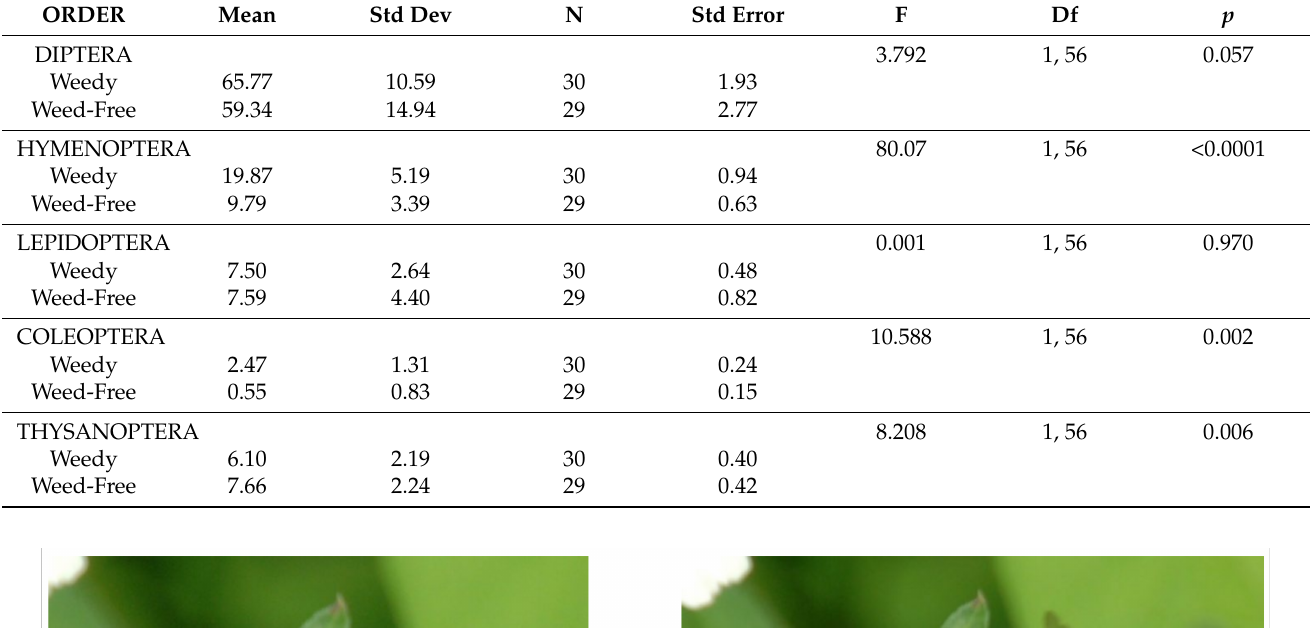
Table 2. Insect orders on mango with or without weeds. Significant differences as shown by GLM Multivariate ANOVA (MANOVA) have p values in bold.